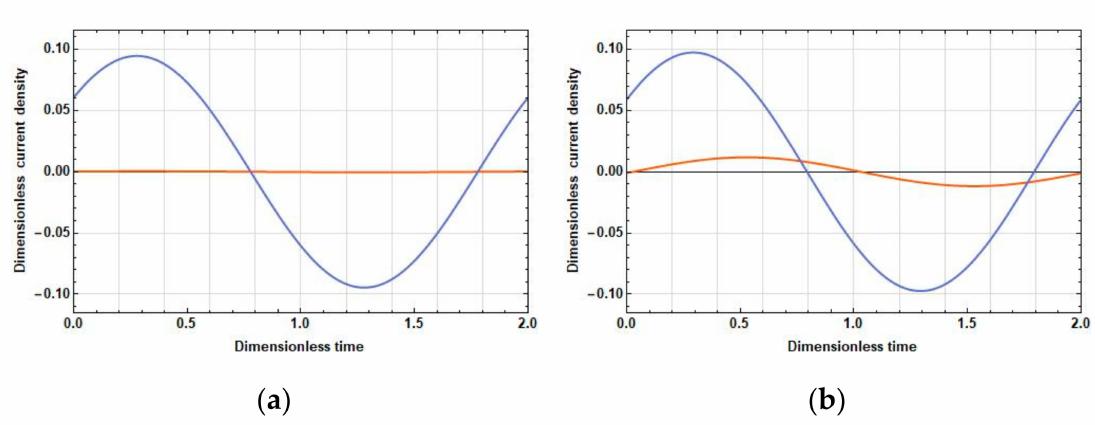
Figure 3. A change in time of a linear density current at the edges of the cathodes during the period of an external signal with the frequency ˜ f = 0.025 at: ( a ) 2˜ l c = 0; and ( b ) 2˜ l c = 1. ˜ B 1,1 (orange lines) is the cathode edge from the side of the other cathode and ˜ B 1,25 (blue lines) is the cathode edge from the side of the adjacent anode.